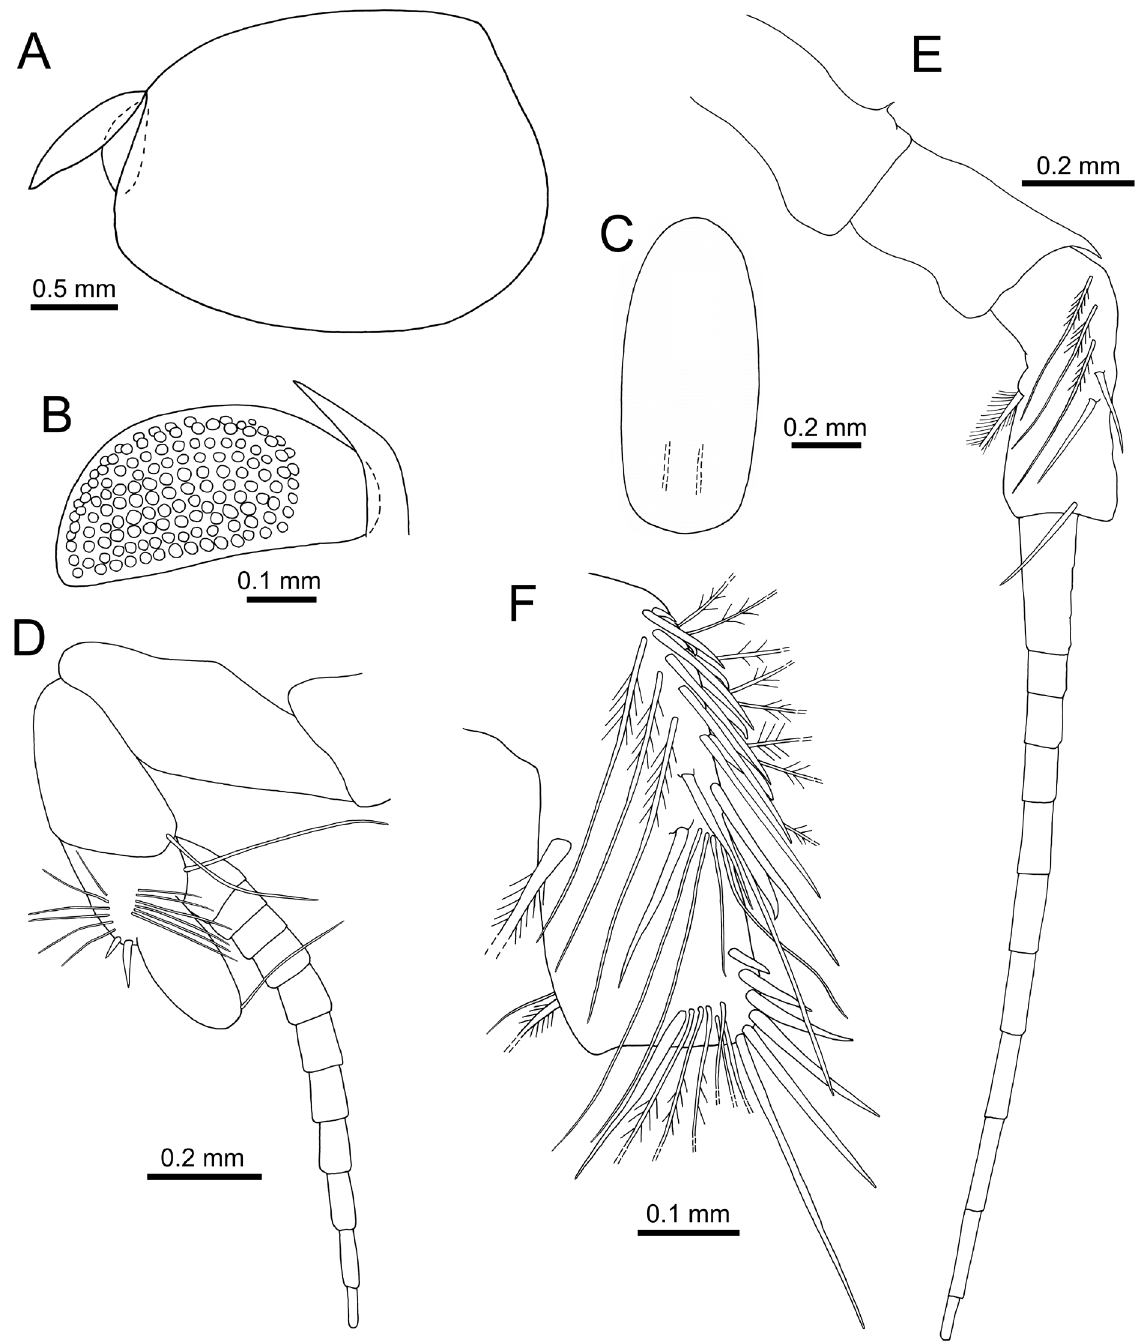
Fig. 2. Nebalia strausi Risso, 1826. Preovigerous female (DBUA0001677.01.W). A . Rostrum, eye and carapace outline, lateral view. B . Eye and supra-orbital plate, lateral view. C . Rostrum, dorsal view. D . Antennule, lateral view. E . Antenna, lateral view. F . Antenna, peduncle third article, lateral view. D–E: only selected setae